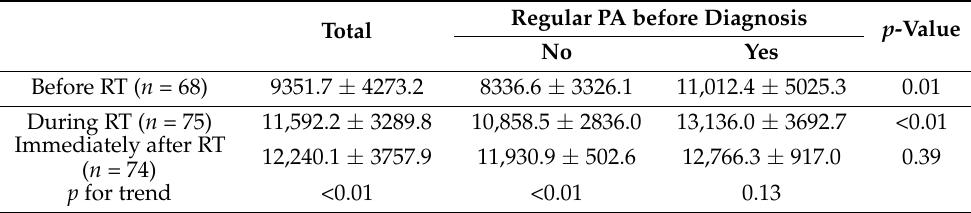
Table 3. Average daily step count (steps/day) in the WAT+counseling group during RT.